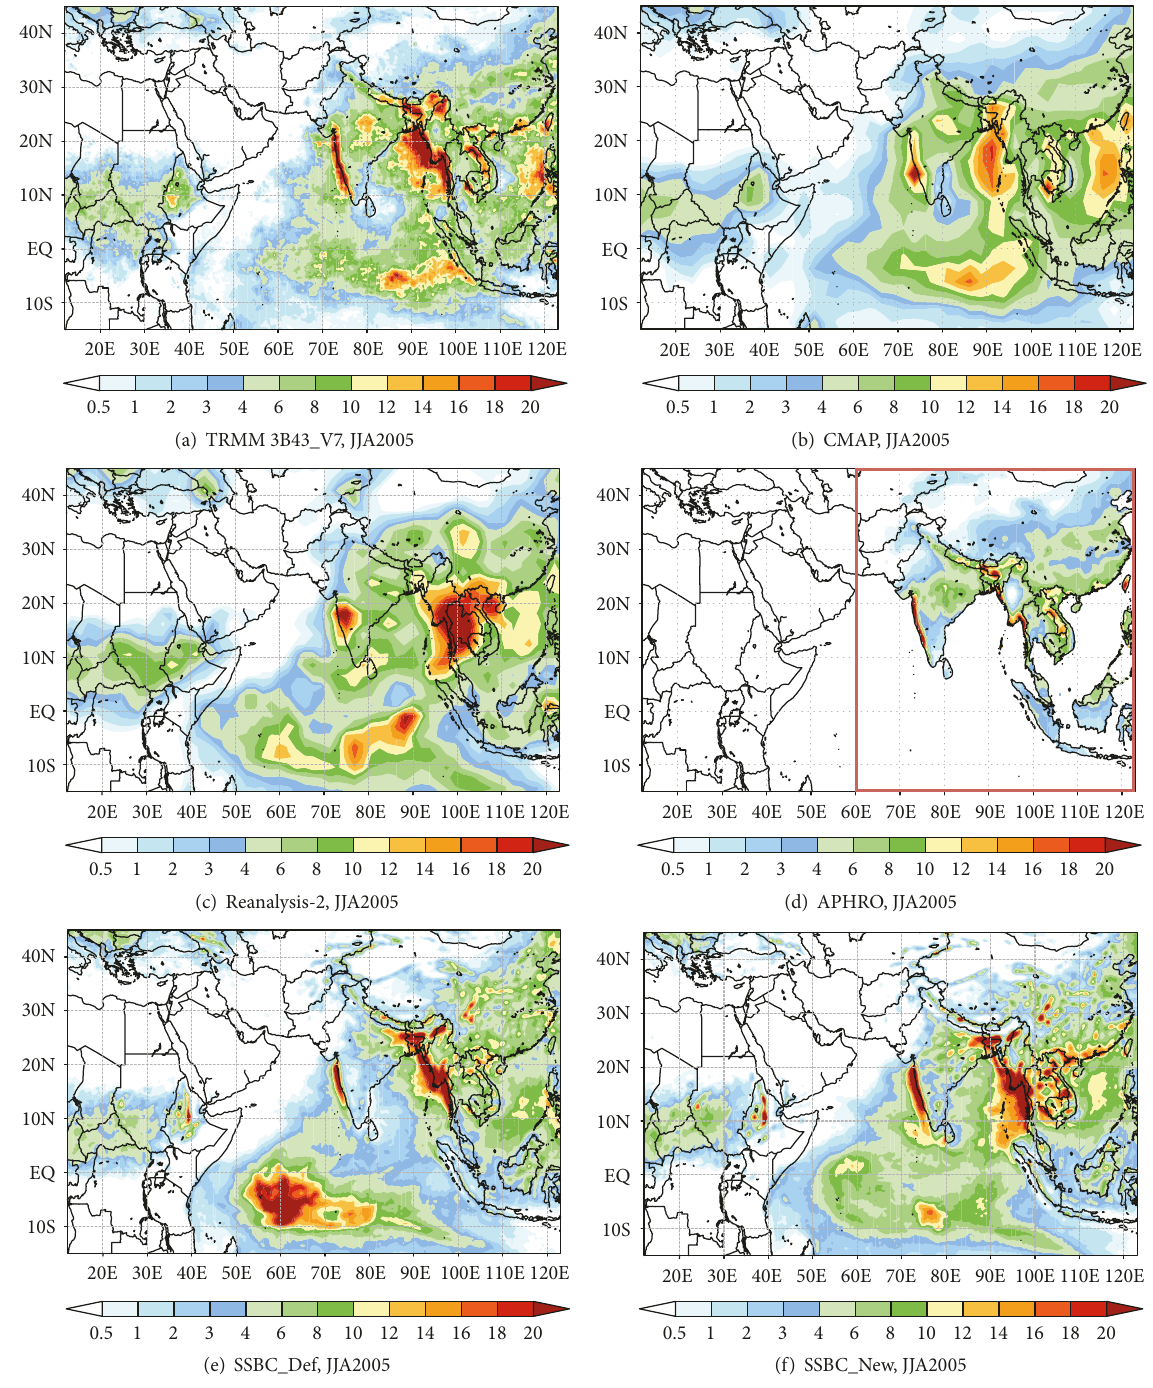
Figure 2: Comparison of SSBC_Def (e) and SSBC_New (f) surface precipitation (mmd −1 ) for JJA, 2005, with TRMM satellite 3B43_V7 (a), CMAP (b), Reanalysis-2 (c), and APHRODITE (d) surface precipitation (mmd −1 ). Red box in (d) indicates the spatial coverage